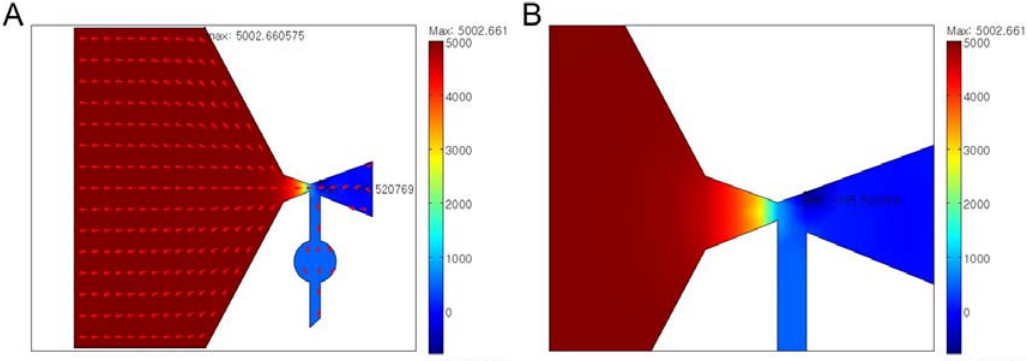
Figure 3. The simulation model and result of the gathering